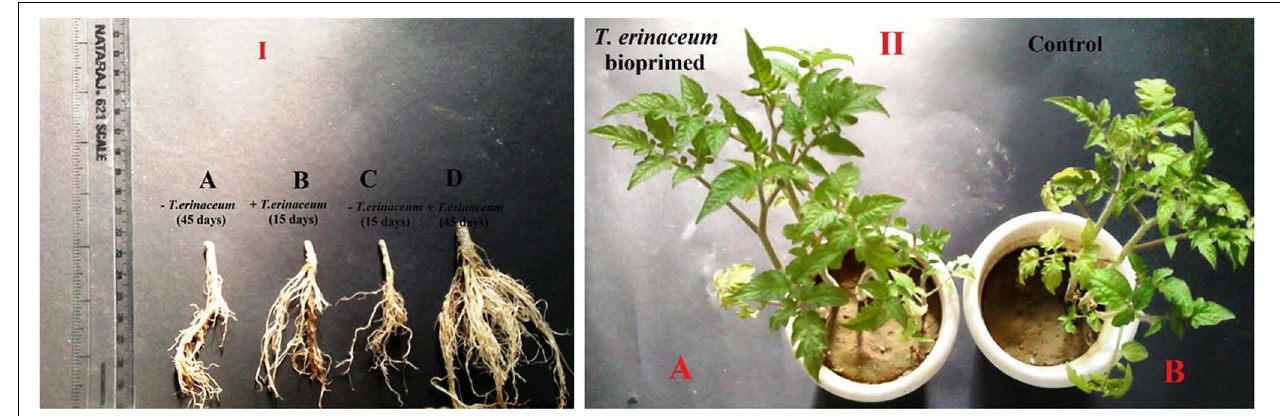
FIGURE 3 | (I) Morphological growth characteristic of the T. erinaceum bioprimed and unprimed plants at two different intervals 15 and 45 days. The T. erinaceum bioprimed samples were found to have had profuse growth with increased plant height, root growth, stem diameter and number of leaves compared to control plants. (A) Picture showing root growth and thickness of stem at root-shoot junction after 45 days in the unprimed plants (B) T. erinaceum bioprimed plants after 15 days (C) T. erinaceum unprimed plants after 15 days (D) T. erinaceum bioprimed plants after 45 days. (II) (A) Pots showing the growth pattern and morphological parameters of unprimed (control) and T. erinaceum bioprimed